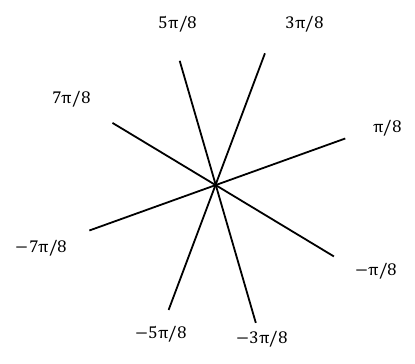
Figure 5. Quantizing the gradient direction with four symbols.